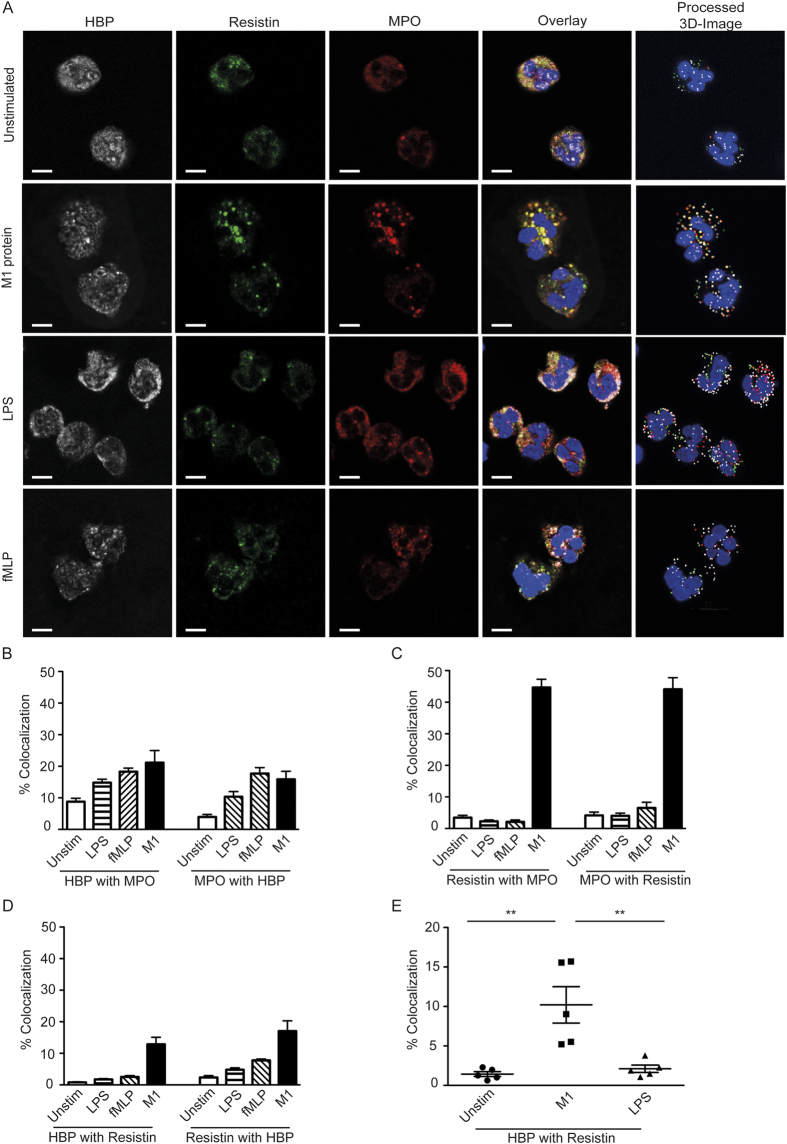
Subcellular localization of HBP and resistin in neutrophils.Neutrophils from healthy donors were isolated and stimulated with LPS (50 ng/ml), fMLP (5 μg/ml) or streptococcal M1-protein (1 μg/ml) for 2 h. The neutrophils were immunoflourescently stained for HBP (white), resistin (green) and MPO (red), the cell nuclei were visualized using DAPI (blue). Using scanning laser confocal microscopy, Z-stacks of the cells were acquired and vesicles positive for HBP, resistin or MPO identified using the Imaris image analysis software (processed 3D-Image). The degree of colocalization between the above-mentioned markers in the processed images was then quantified using Imaris analysis software. (A) Shows images of cells from a high responder. Bars indicate 5 μm. (B–D) Percentage of co-localization between factors as indicated. (E) Differences in co-localization in neutrophils unstimulated or stimulated with either M1-protein or LPS. Statistical significant differences were determined using the Mann Whitney test, **P < 0.01. Data represent results obtained from multiple field analyses of two experiments using different donors.